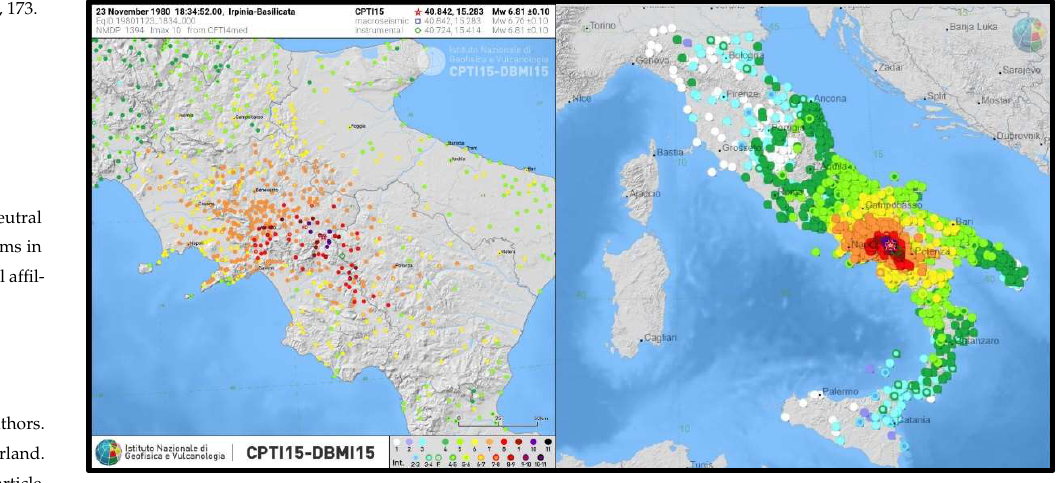
Figure 1. Intensity felt reports of the Irpinia-Basilicata 23 November 1980 earthquake (modified by CPTI15 [2]).